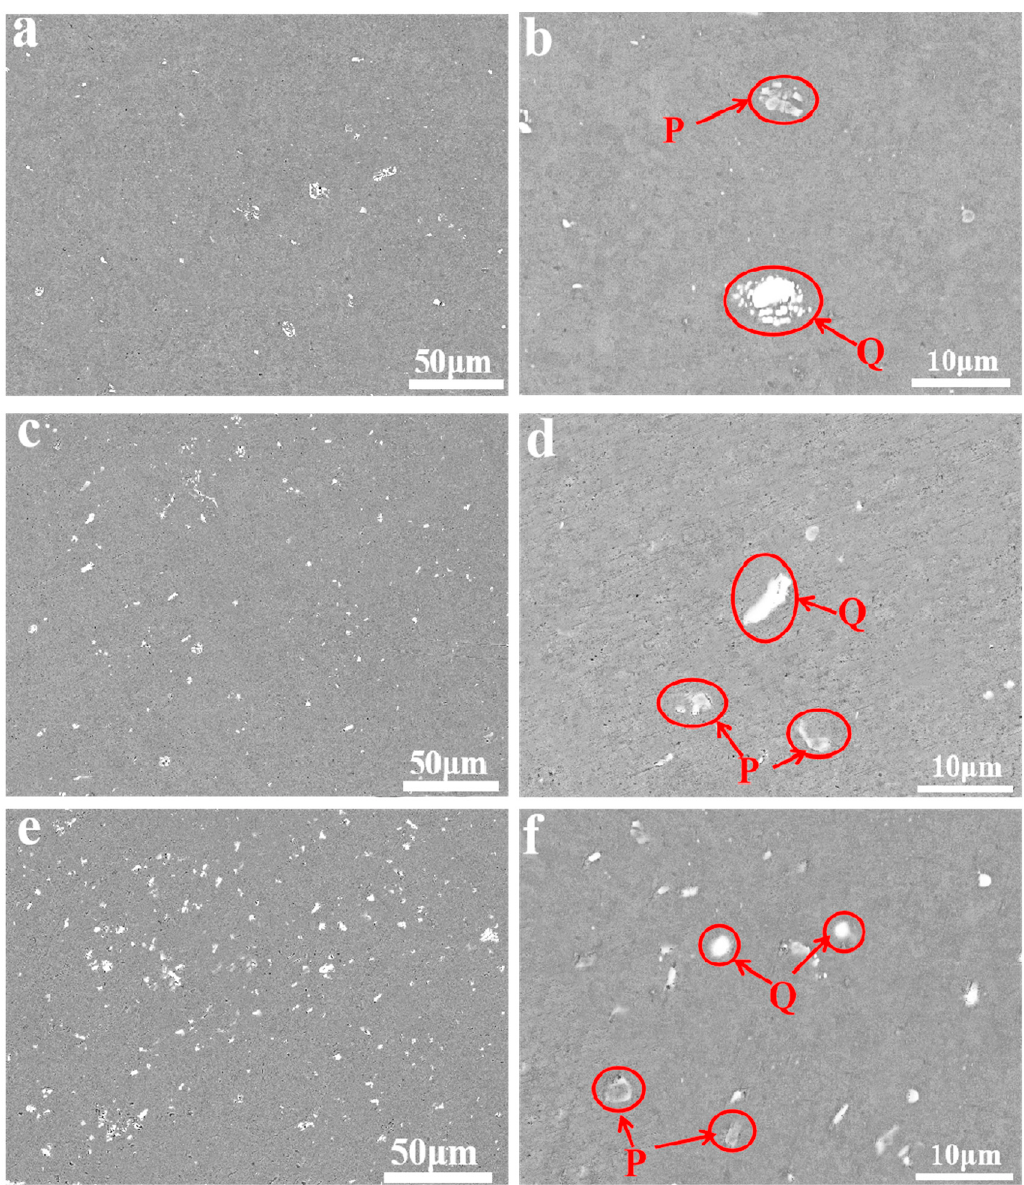
Figure 1. SEM/BSE images of aluminum alloy foils: ( a ) and ( b ) Al-0.07Fe-0.07La; ( c ) and ( d ) Figure 1. SEM / BSE images of aluminum alloy foils: ( a , b ) Al-0.07Fe-0.07La; ( c , d ) Al-0.1Fe-0.07La; Al-0.1Fe-0.07La; ( e ) and ( f ) Al-0.2Fe-0.07La. ( e , f )